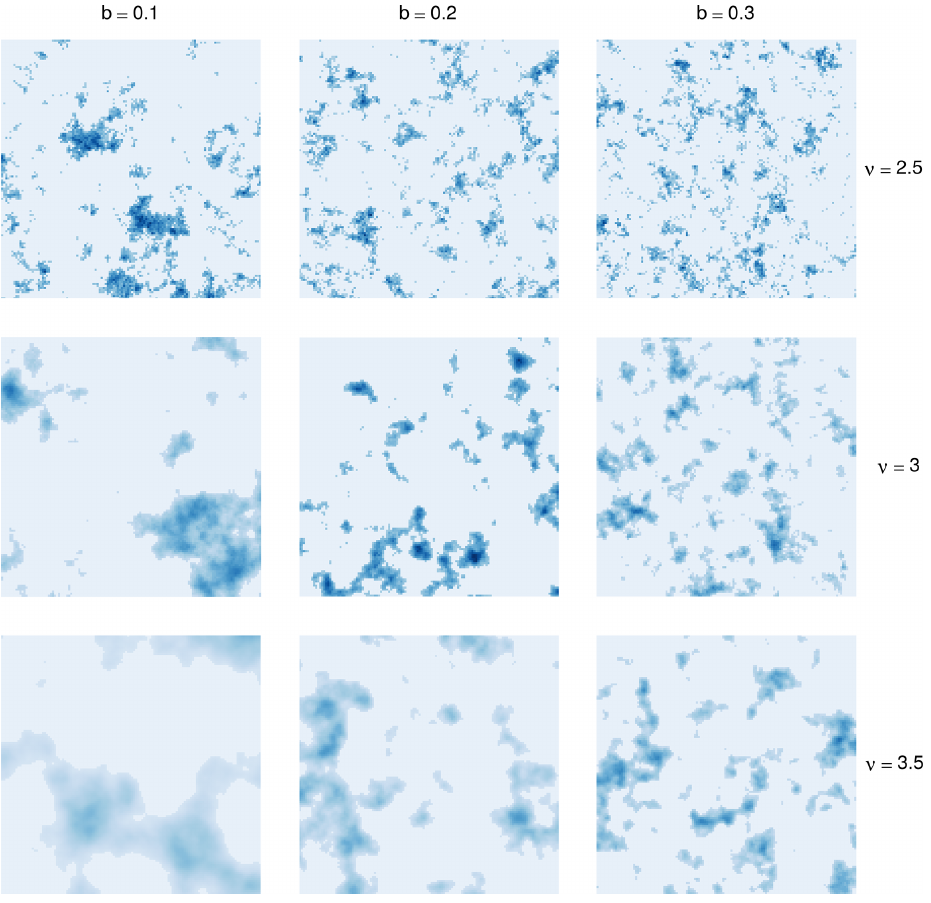
Figure 1. Example realizations of the stochastic rain model on a 128 × 128 grid for various choices of scale b and smoothness ν . The threshold T was chosen such that 20% of the field has non-zero